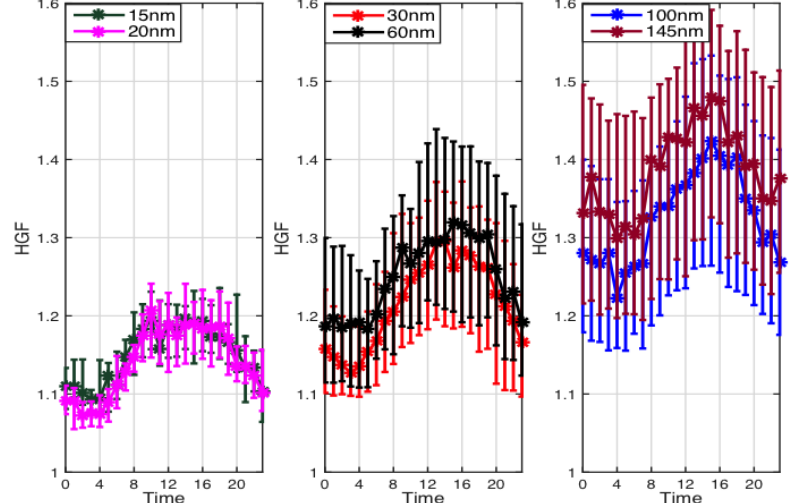
Figure 2. Diurnal variation of hygroscopic growth factor of particles with size of 15, 20, 30, 60, 100 and 145nm during the measurement period.